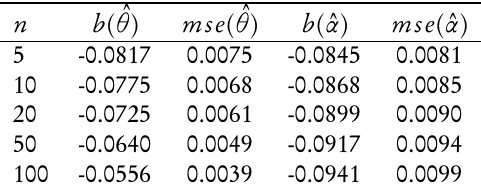
Bias and mean square error of the m.l.e.’s ( ˆ θ , ˆ α ) , for the intermediate binomial distribution {